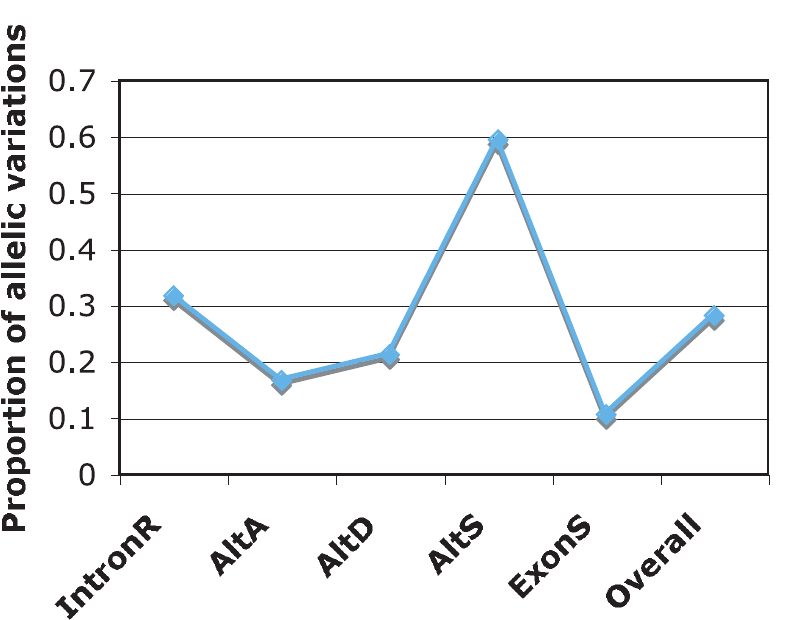
Figure 4. Distinguishing allelic gene structure variations from alternative splicing. Upper panel shows a diagram using SNP on EST as tags to distinguish allelic variations from alternative splicing with one AltA case. The light boxes are exons, the lines linking these boxes represent introns, and the numbers above the lines are intron length. The letters within boxes indicate the SNPs at a specific position labeled in different ESTs (gi numbers are shown on the right). In the example here, the SNP pattern T-A-T is associated with one transcript isoform, while SNP pattern G-G-C is associated with another transcript isoform. SNPs existing in multiple ESTs were used to distinguish the allelic variations from alternative splicing (see methods), and ESTs that didn’t have mSNP were removed from the estimations. Lower panel shows the frequency distribution of allelic gene structure variations in TSVs based on this method.